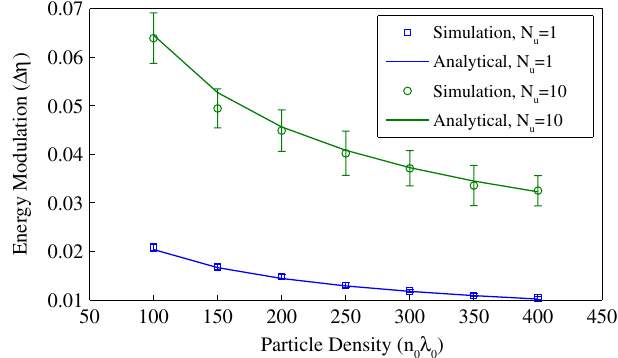
FIG. 13. Energy modulation h (cid:5) (cid:1) i induced by the interaction [Eq. (C3)] is compared to the result of repeated simulations for the undulator case. The final energy spread is given as a function of the particle per wavelength n initial energy spread (cid:2) (cid:1) ¼ 0 .